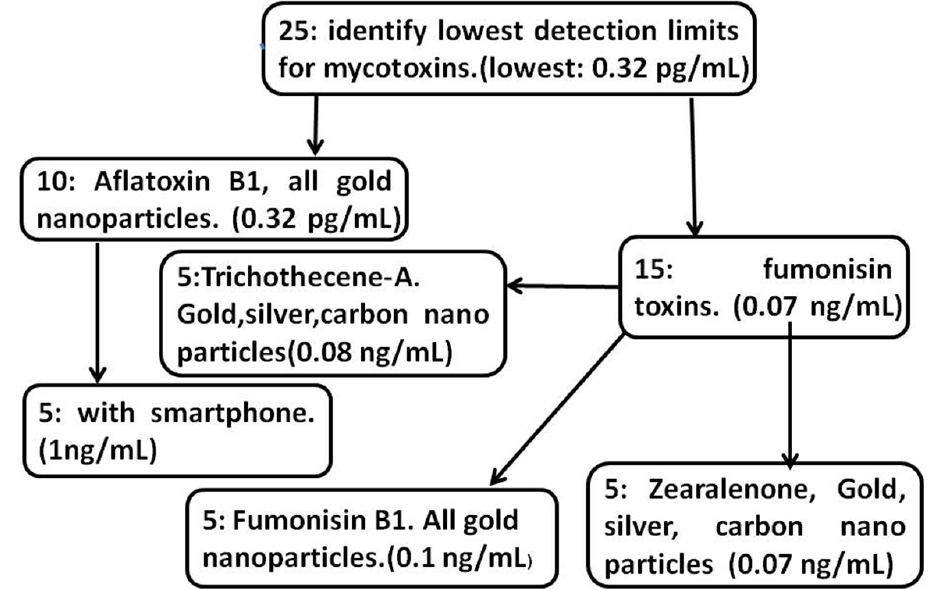
Figure 1. Hierarchy of analysis of papers dealing with limits of different mycotoxins.